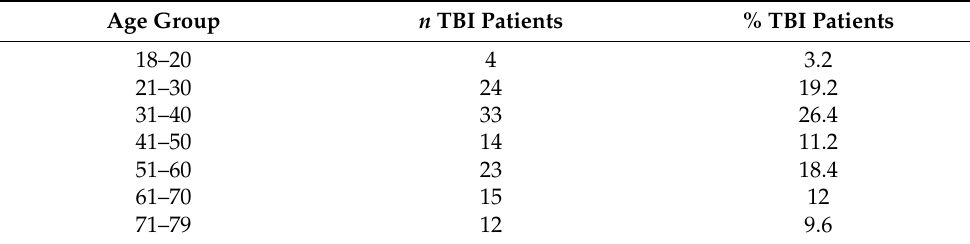
Table 4. TBI patients’